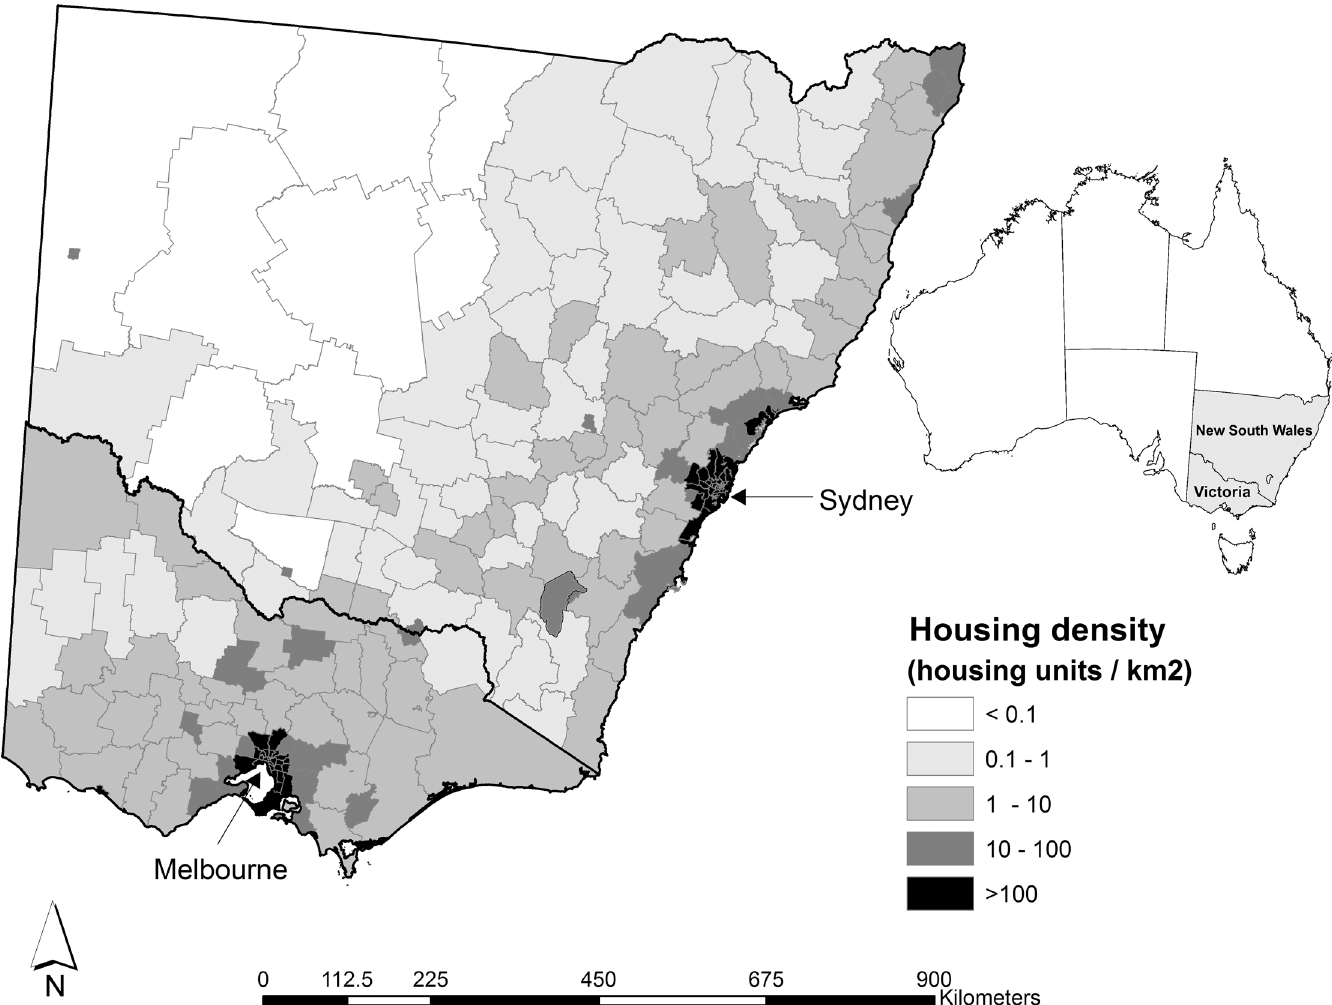
Fig 1. Location of study area and housing density, housing units/km 2 in relation to local government areas. Source: generated from data from the Australian Bureau of Statistics 2011 Census of Population and Housing. Developed using Administrative Boundaries produced by PSMA Australia